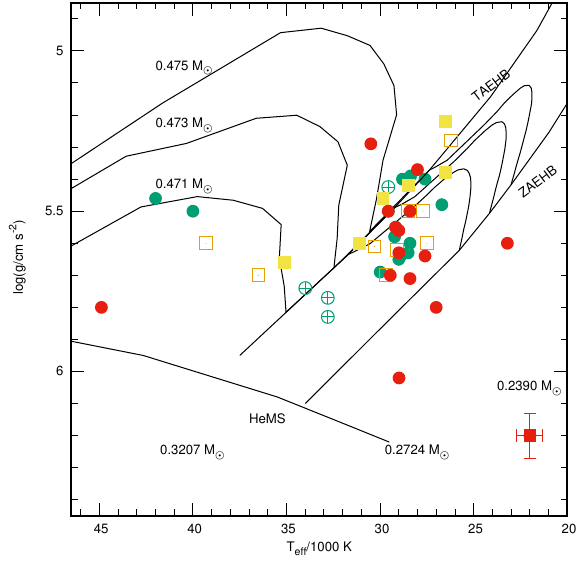
Figure 7. T eff − log g diagram of primaries of the reflection effect systems with known parameters. Open symbols represent pulsating systems. The green circles represent the known HW Vir systems, and the yellow squares represent the systems without eclipses. The red circles represent the analyzed HW Vir systems from the OGLE survey. The red square gives the typical statistical